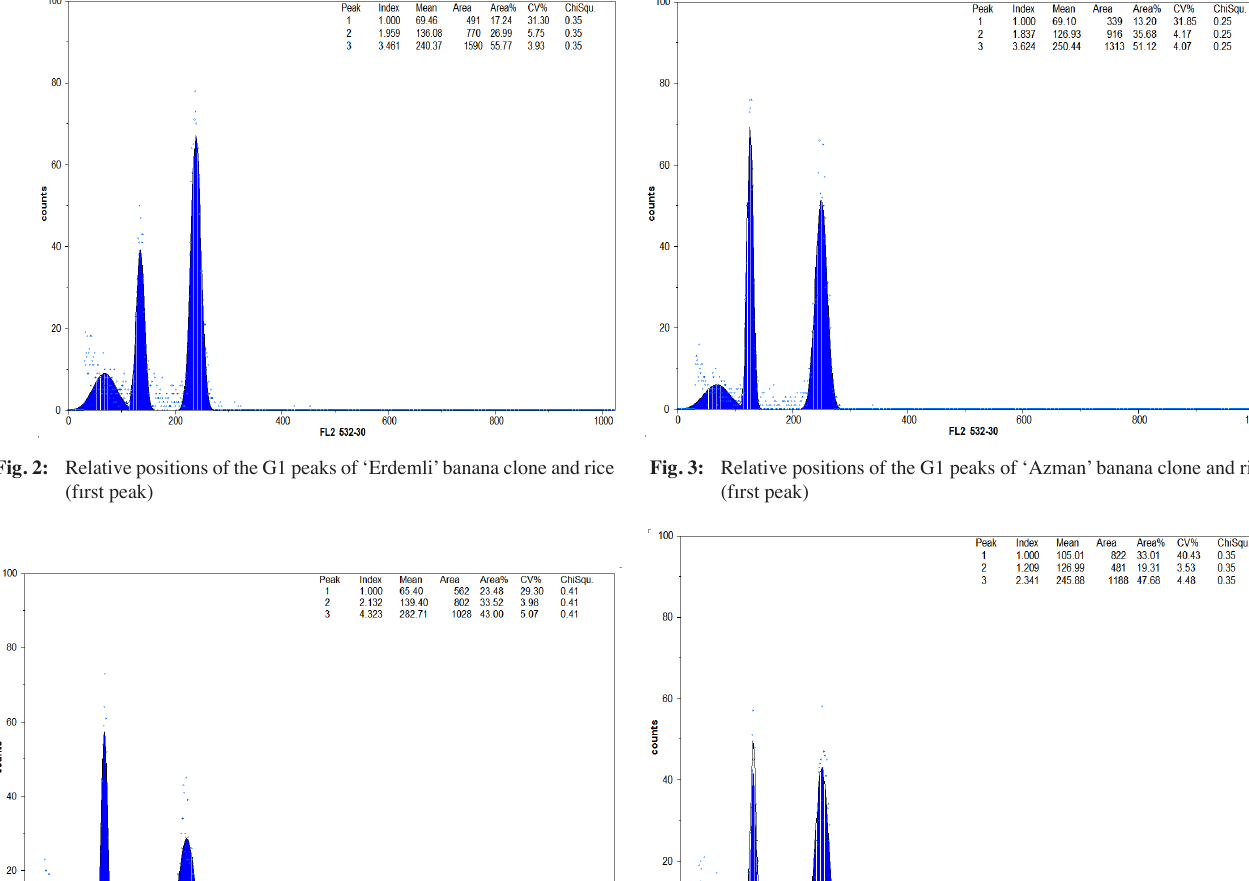
Fig. 4: Relative positions of the G1 peaks of ‘Grand Nain’ banana clone and rice (fırst